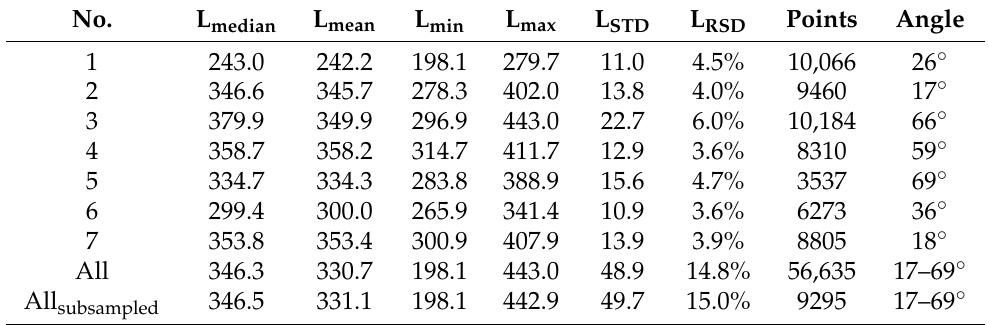
Table 9. The vertical sample area: median luminance, Gaussian mean luminance, minimum lumi- nance, maximum luminance, standard deviation, relative standard deviation, number of points, and angle between the surface normal and the measurement direction.